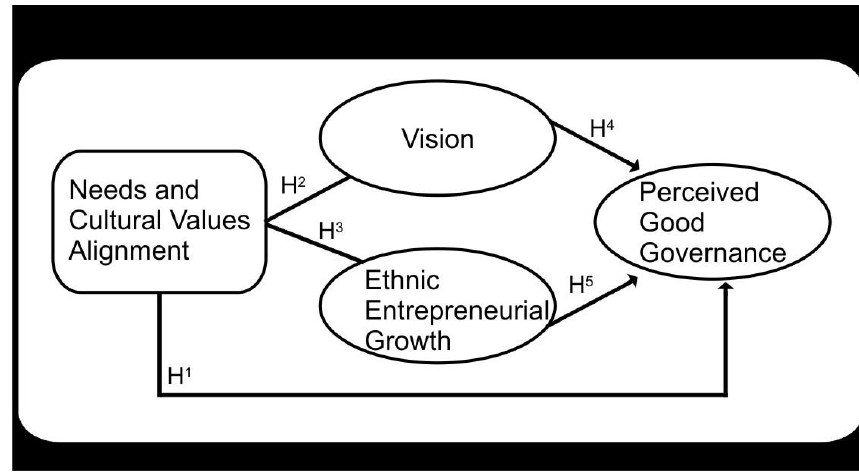
Figure 1: Hypothesised